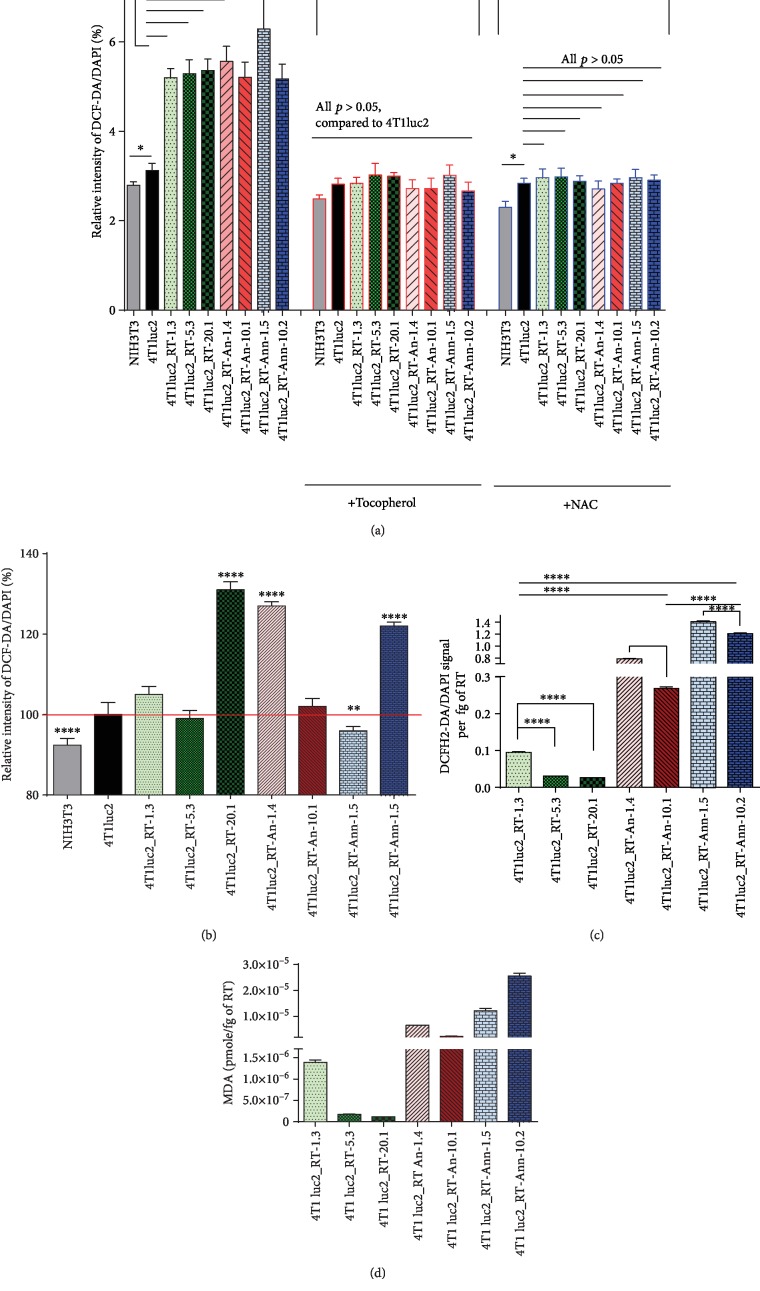
Derivatives of 4T1luc2 cells expressing variants of consensus HIV-1 FSU_A reverse transcriptase (Table 2) exhibit increased levels of ROS production (a–c) and lipid peroxidation (d). ROS production was measured using fluorescent dye DCFH2-DA and normalized to the signal generated by DAPI staining. Total levels of ROS per cell on day 6 of cell culture; production of ROS is quenched by treatment with antioxidants tocopherol (1 μM) and NAC (5 mM); red asterisk indicates significant differences between 4T1luc2_RT-Ann-1.5 and other RT-expressing variants (p < 0.05) (a). Total levels of ROS production per cell on day 14 of cell culture relative to the levels exhibited by the parental 4T1luc2 cells (b). ROS levels on day 14 of cell culture normalized to the amount of RT_A variant (in fg) produced by one cell (c). Level of lipid peroxidation on day 14 of cell culture assessed as the concentration of MDA in the lysate of a single cell normalized to the amount of RT_A variant (in fg) produced by one cell (d). Values represent mean ± SD from two independent assays run in duplicates. ns: not significant; ∗p < 0.05; ∗∗p < 0.01; ∗∗∗p < 0.001; ∗∗∗∗p < 0.0001 (Kruskal-Wallis, followed by Mann-Whitney tests or ordinary one-way ANOVA followed by unpaired t-test).